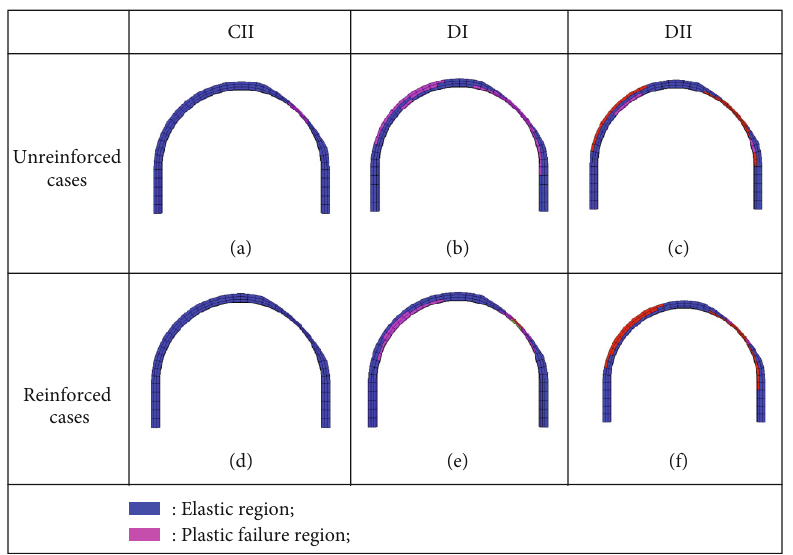
Figure 11: Plastic failure region on lining concrete for tunnel with a cavity on the shoulder.